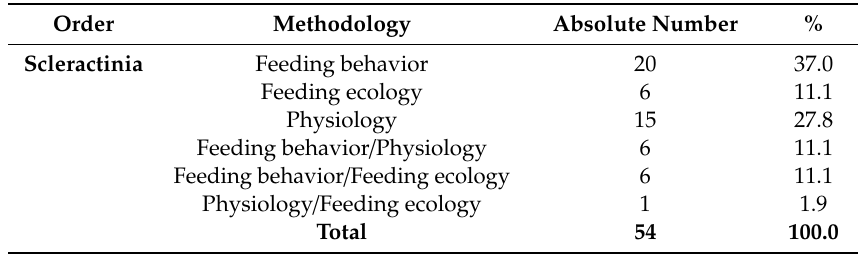
Table 4. Approaches of feeding studies examining